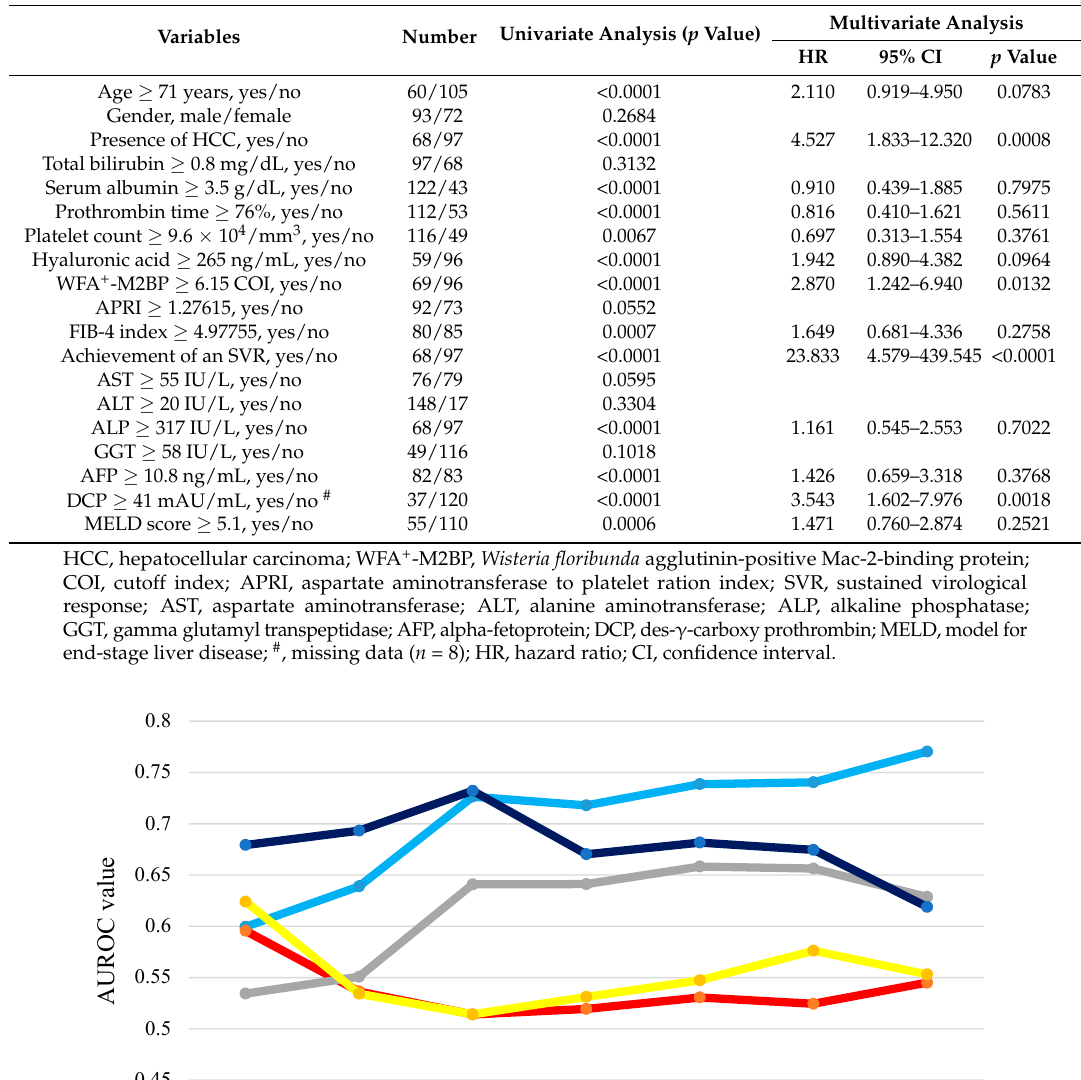
Table 2. Univariate and multivariate of factors associated with overall survival.